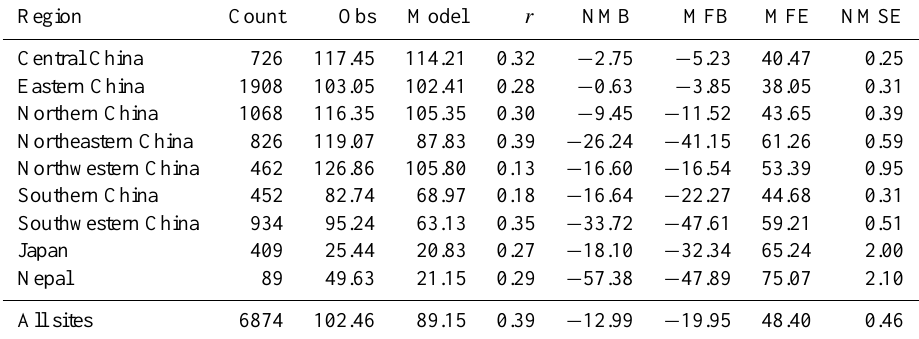
Table 3. Statistical performance of WRF-Chem–REAS simulations for PM 10 in 2007. Count is the total number of observations for calcula- tion; Obs (µgm − 3 ) and Model (µgm − 3 ) are 4-month mean daily average value of observations and model simulations, respectively. Other indicators and associated units are described in Table 2.